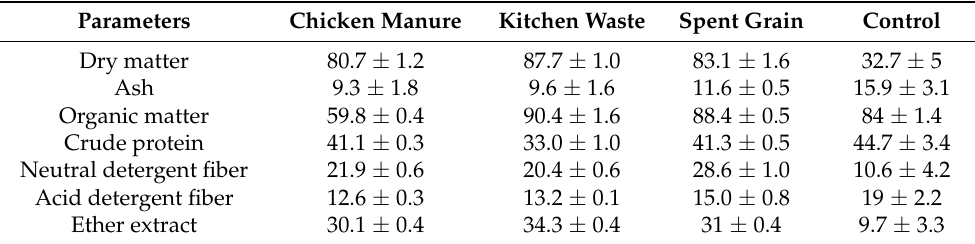
Table 2. Chemical composition of black soldier fly larvae, with percentages adjusted